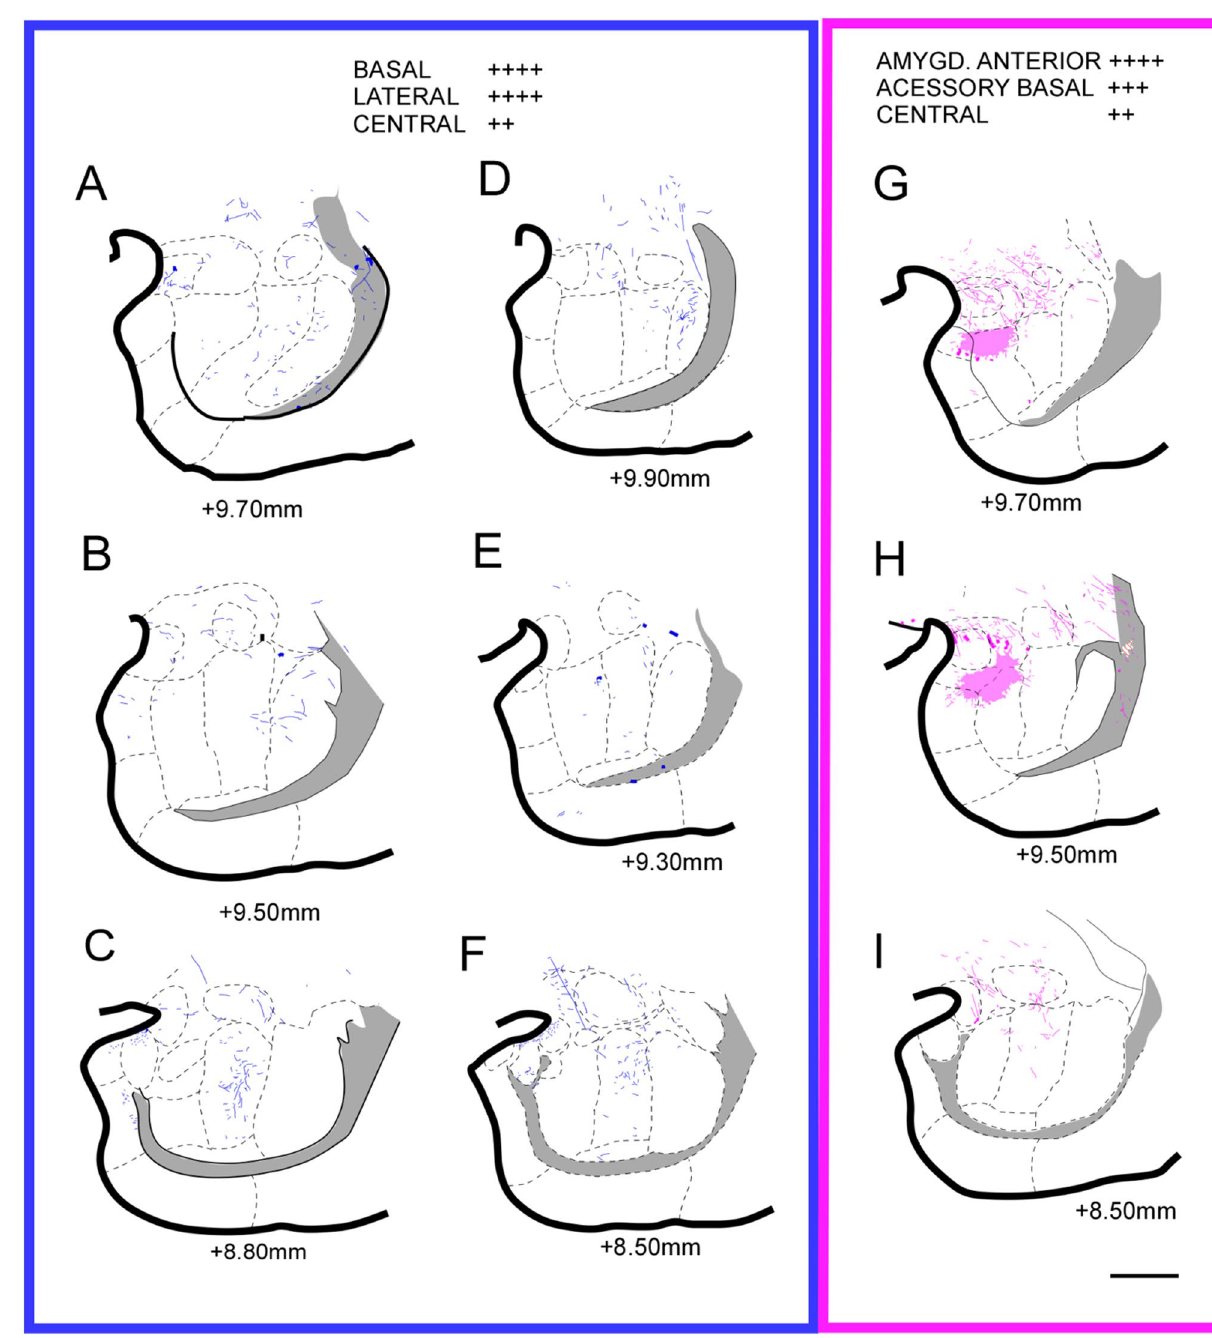
Figure 9. Location of the fibers from the A32 (blue) and A25 (purple) cortex in the amygdaloid complex. ( A – C ) case 1; ( D–F ) case 2; ( G–I ) case 3. The shaded area corresponds to the plexuses: high density of fibers. Scale bar: 1000 µm . The figure was drawn in Canvas software version 12.0 76